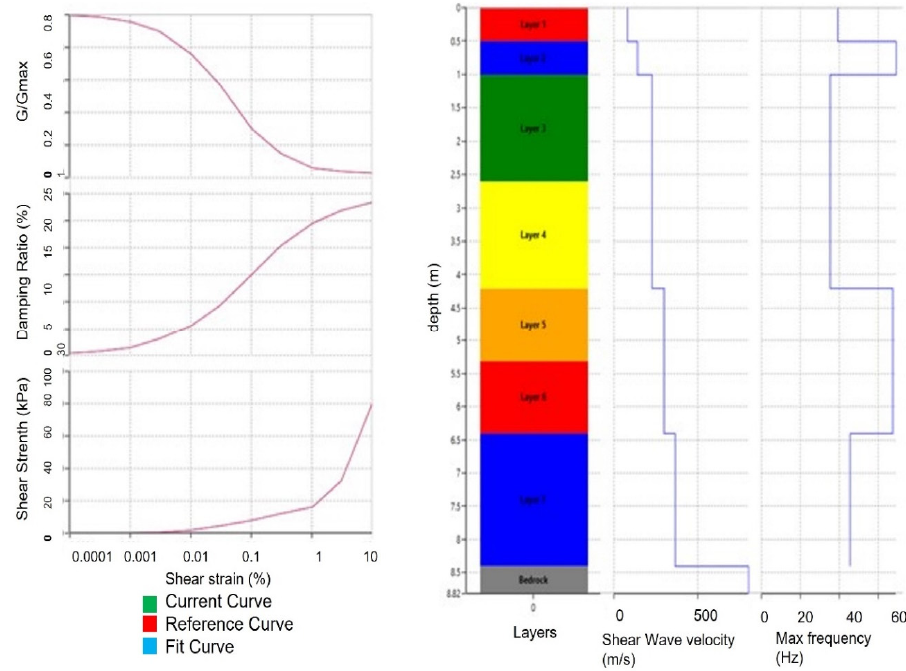
Figure 4. G/Gmax, damping ratio (%) and shear strength (kPa) curves according to Seed and Idriss (1970) ( left ); and the stratigraphic profile model implemented in DeepSoil software and relative shear wave velocity (m/s) ( right ).